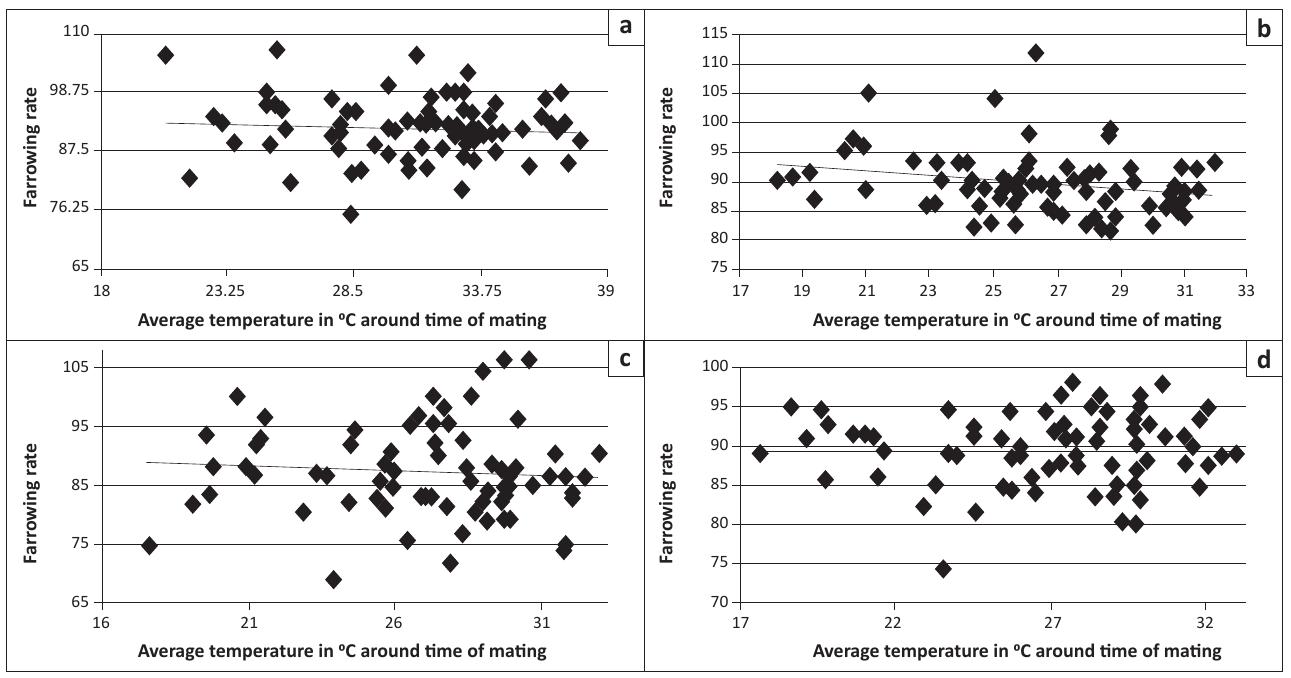
tt li e a g e r A v